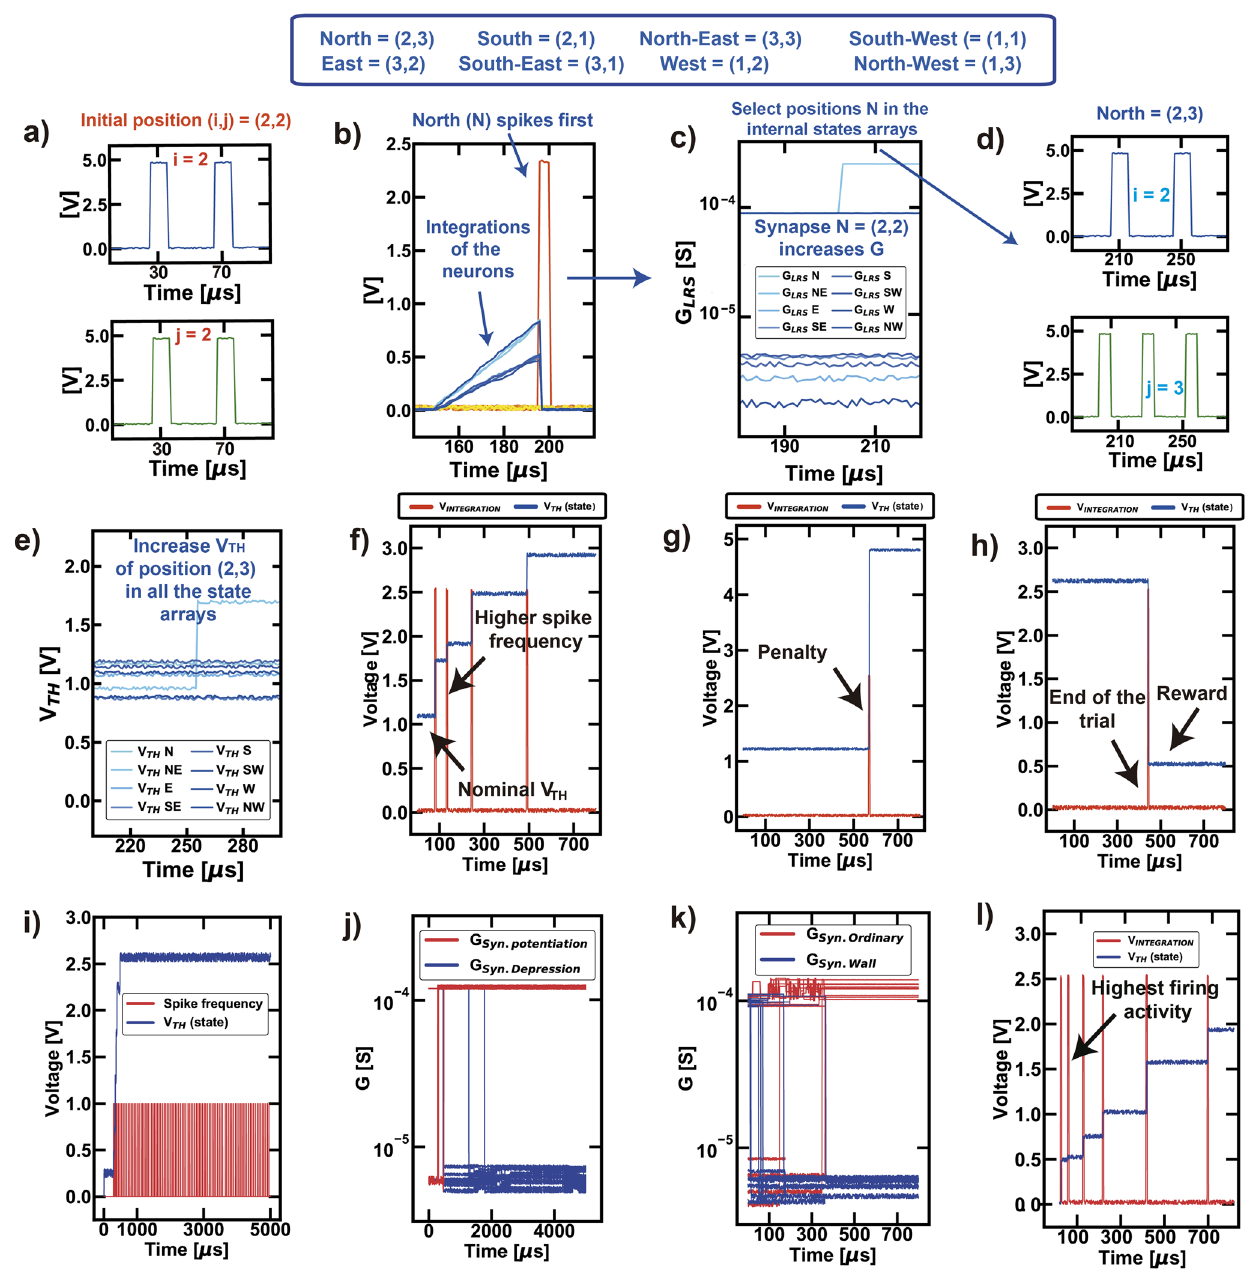
Fig. 3 | Step-by-step description of the main signals ruling the autonomous navigation.a TheFPGArecordsthecurrentpositionoftheagentand b triggersthe gate voltage signal of the synaptic devices to start the integration phase of the nearest neurons. Once a neuron fi res, all the integration signals are discharged by switching on a transistor in parallel to the capacitor used for integration. After the fi re event, the corresponding synaptic connection is brought high ( c ) and